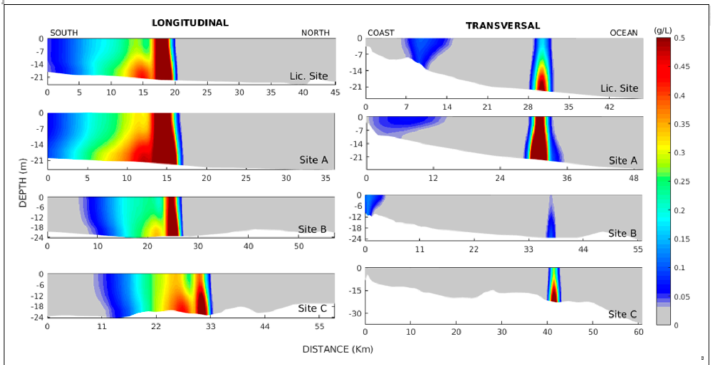
Figure 6. Longitudinal ( left column) and transversal ( right column) profiles representing the disper- sion plume throughout the vertical after 6 discharges (starting on 02 November 2013 at 06:00 h) on the licensed and alternative disposal Sites A, B, and C. Color scale indicates suspended sediment concentrations (g/L), where gray indicates concentrations lower than 0.025